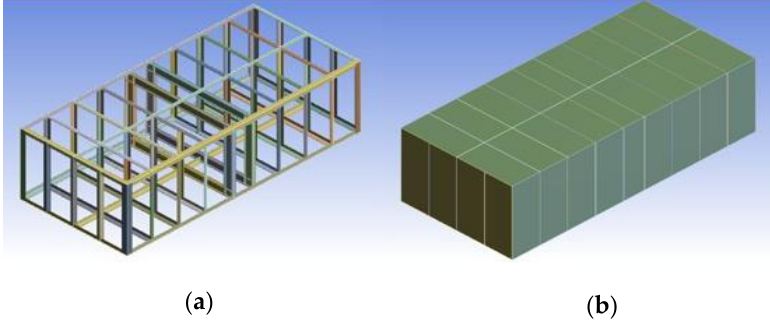
Figure 5. The isometric sections of one pontoon. ( a ) Internal stiffeners configuration, ( b ) Outer shell plates.